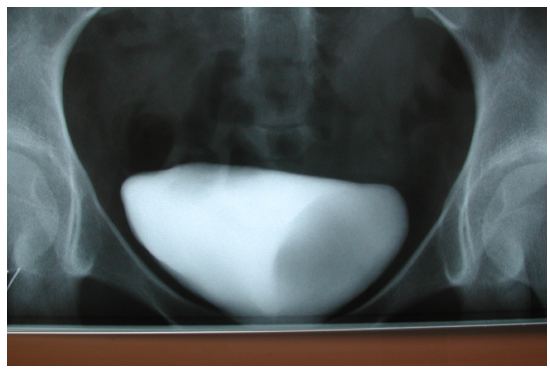
FIGURE 4. Ureterocele on VCUG. Filling defect due to a